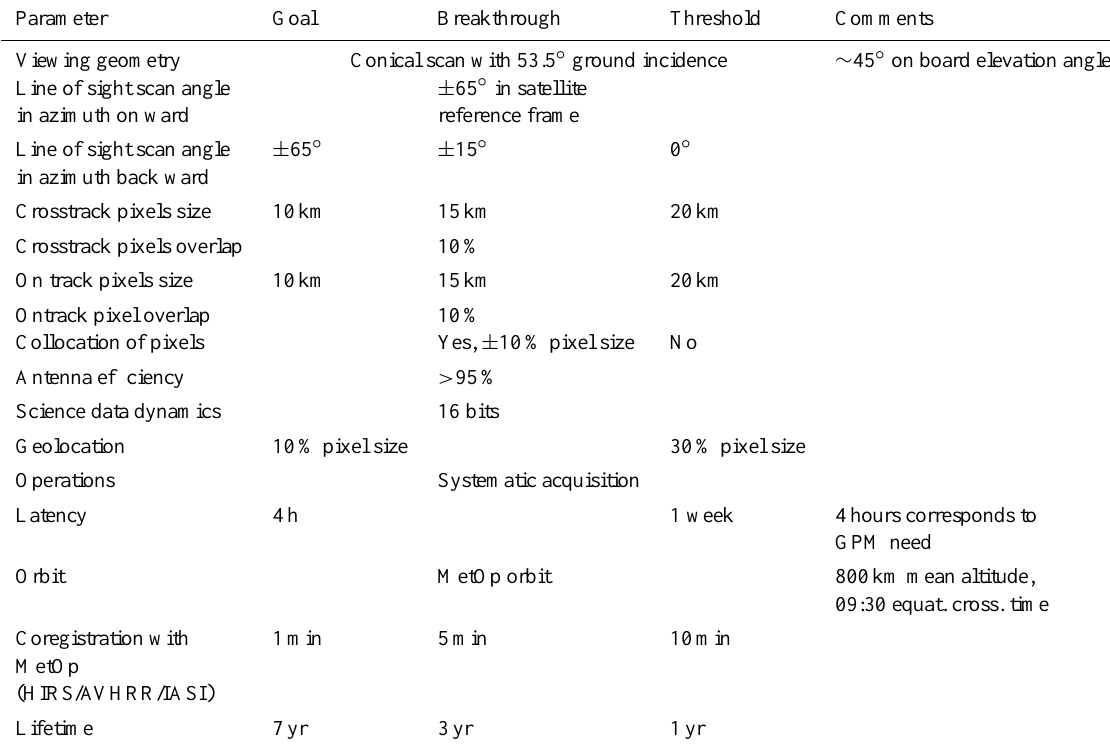
Table 4. A summary of CloudIce system requirements. Goal, breakthrough, and threshold are given where relevant, otherwise only